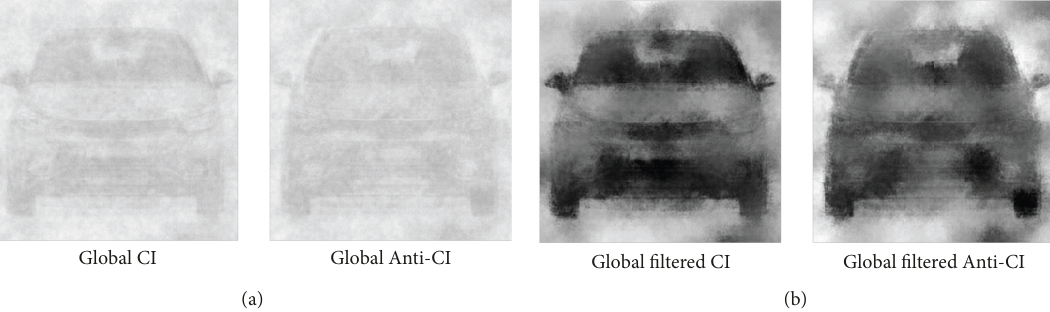
Figure 5: (a) Global CI and anti-CI and (b) global CI and anti-CI after the blur and shadow/highlight compensation filters were